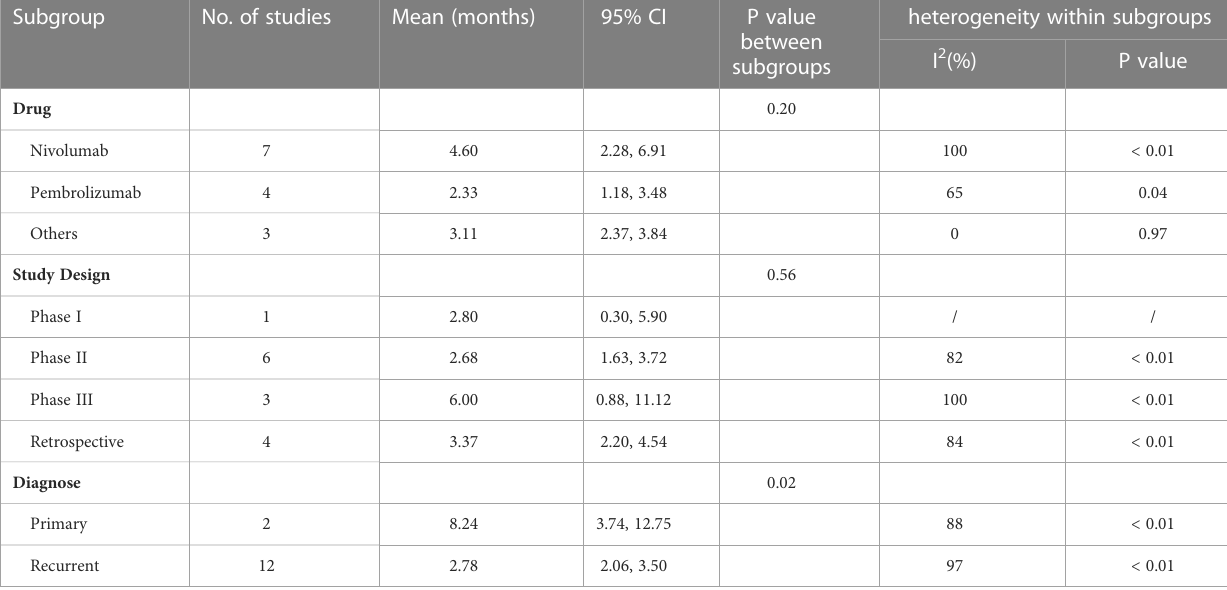
TABLE 3 Subgroup analysis of pooled estimates of the median progression-free survival.